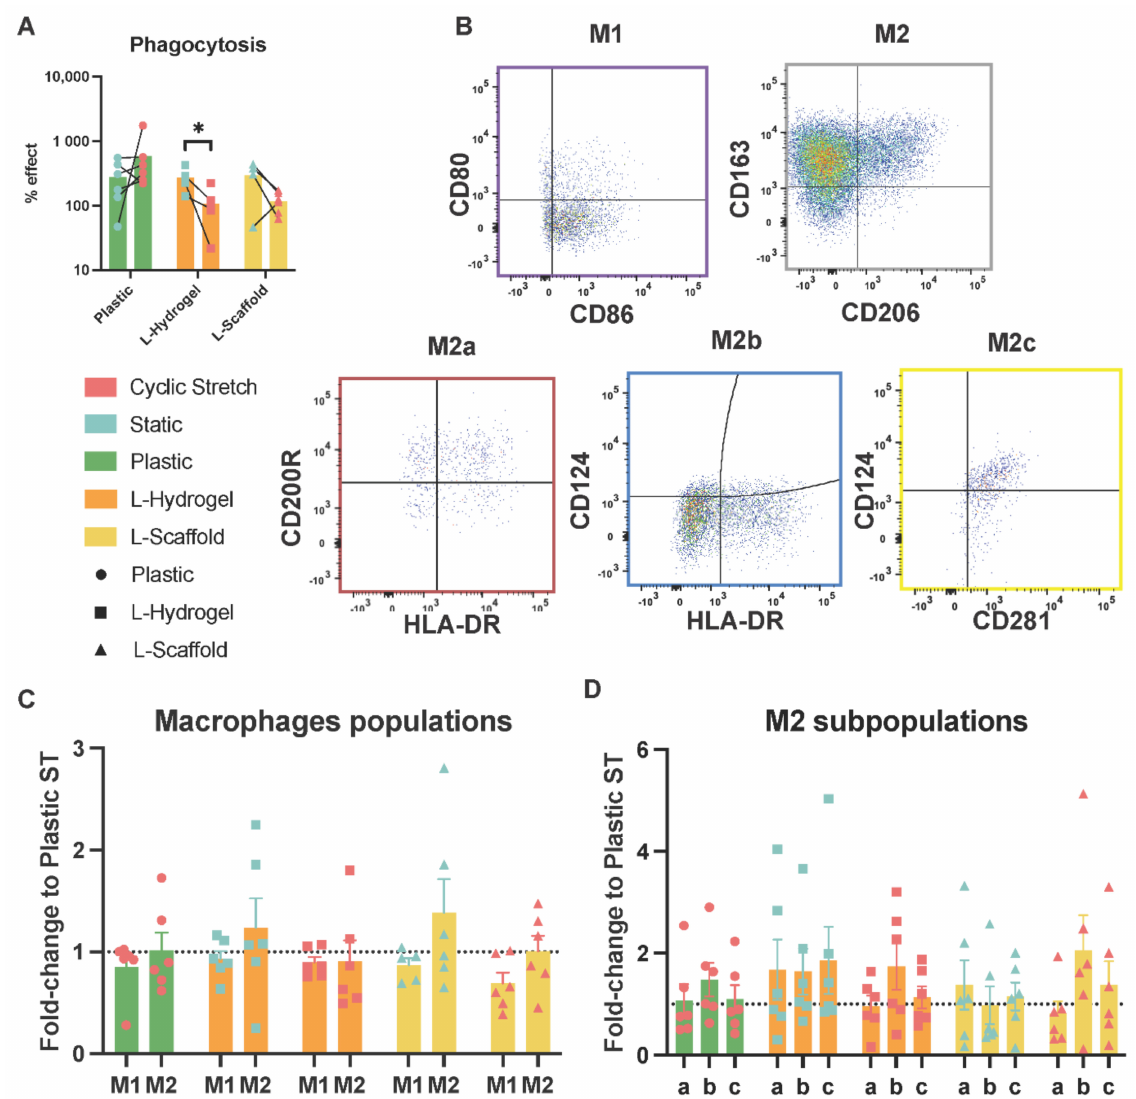
Figure 3. Macrophage activity modulated by the secretome of physiomimetically cultured hLMSCs. ( A ) Phagocytosis is expressed as % effect compared to the positive control of the assay. * p = 0.0317. ( B ) Gating strategy to sort the macrophage population and the M2 subpopulations; ( C , D ) Macrophage subpopulations expressed in fold changes to plastic ST. Bars show mean values for the different conditions assayed: green (plastic), orange (L-Hydrogel) and yellow